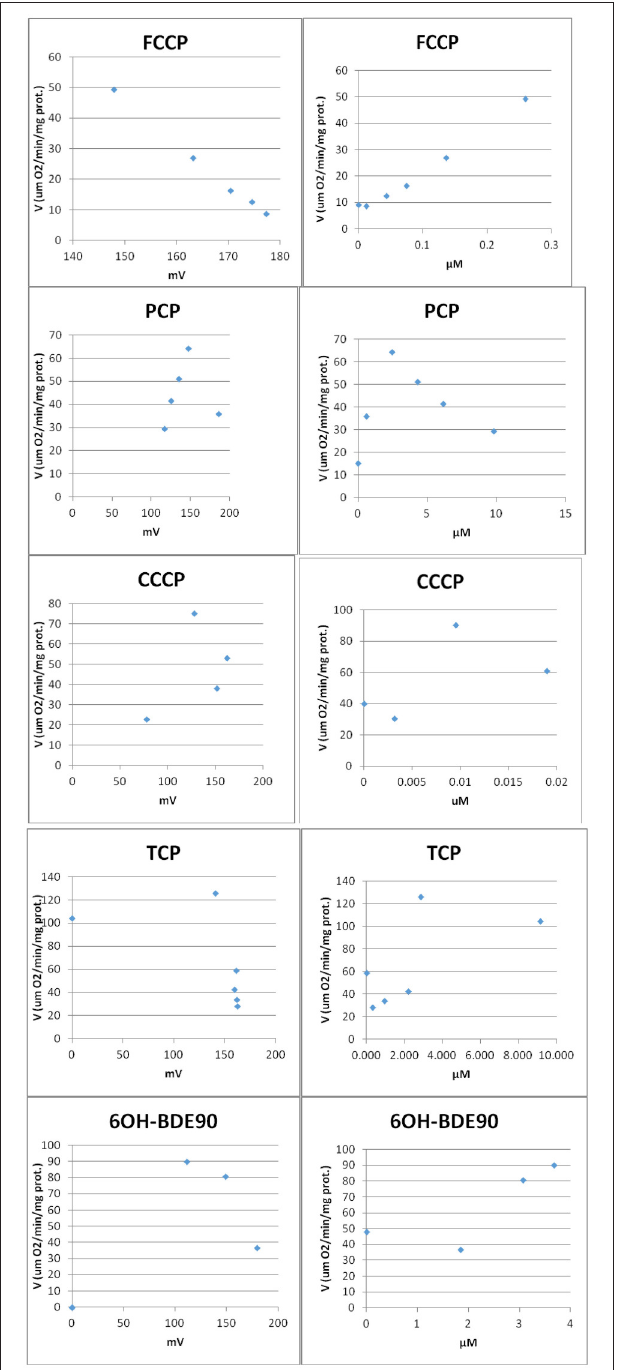
FIGURE 2 | Dose-response curves for single compounds in the TPP + assay. Measurement of respiration rate (V) vs. mitochondria membrane potential (MMP) (Left) . Each point represents the measurements after compound was added to the vessel. After addition of compound the membrane potential decreases (non-disrupted MMP ∼ 180mv) and the oxygen consumption increases (uncoupling). At higher concentrations, the oxygen consumption starts to decrease indicating inhibition. Measurement of respiration rate (V) vs. concentration of compound (Right) . After addition of compound the oxygen consumption increases (uncoupling). At higher concentrations, the oxygen consumption starts to decrease indicating inhibition.